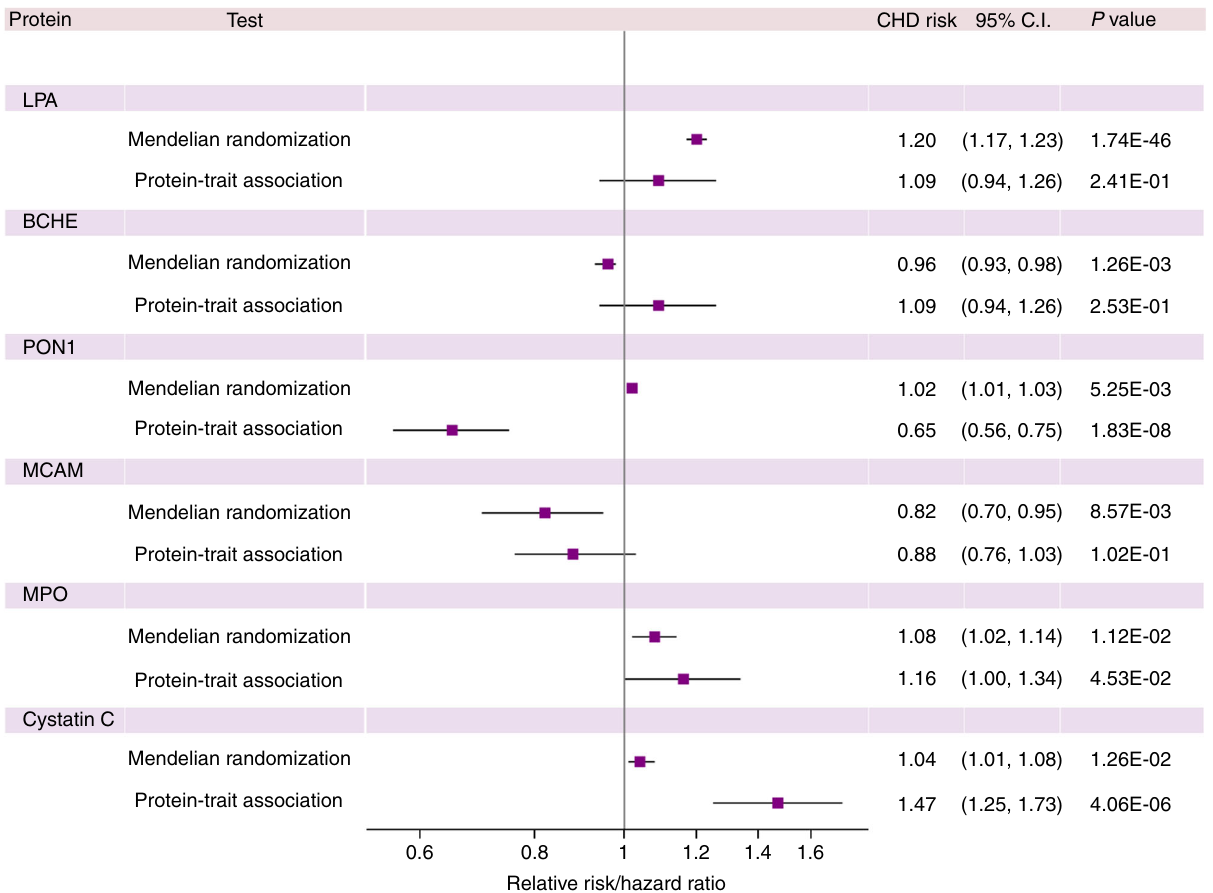
Fig. 5 Protein effects on coronary heart disease from Mendelian randomization and observed protein-trait associations. A comparison of protein effects on risk of CHD estimated from Mendelian randomization vs. the observed protein-trait associations hazards ratios. CHD coronary heart disease, CI con fi dence interval; CHD risk (per standard deviation increase in inverse-normalized protein